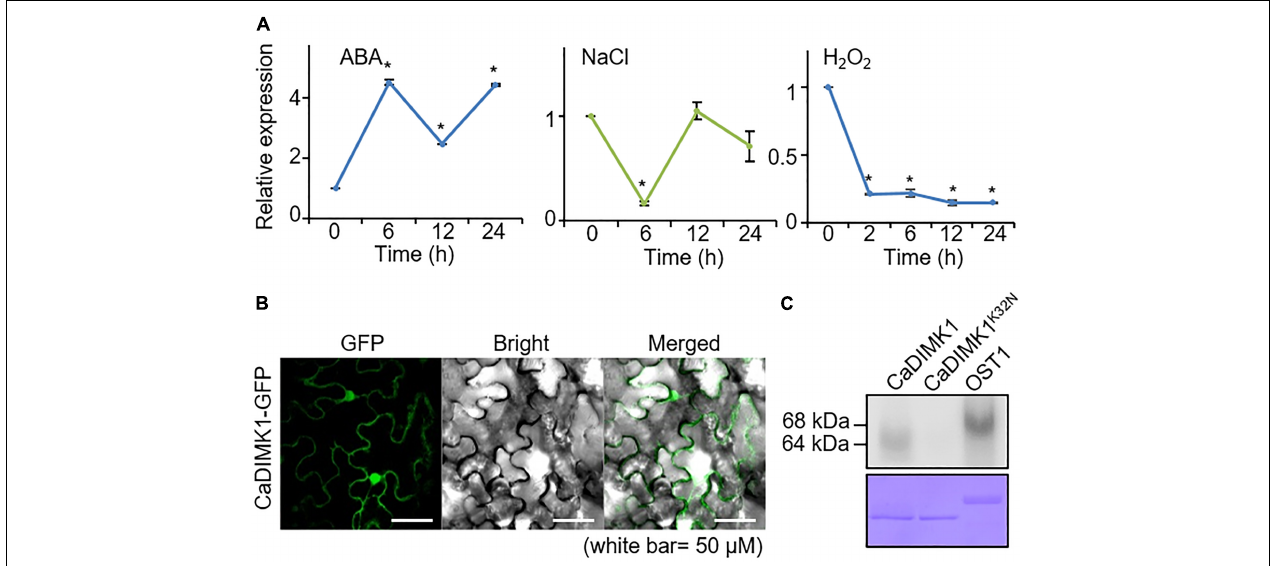
FIGURE 3 | Expression of CaDIMK1 gene and subcellular localization of CaDIMK1 protein. (A) Induction levels of CaDIMK1 in pepper plant leaf tissue treated with abscisic acid (ABA; 100 µ M), sodium chloride (NaCl; 200 mM), and hydrogen peroxide (H 2 O 2 ; 100 µ M). The expression values are normalized to pepper Actin1 ( CaACT1 ) gene as a standard control. The induction level of CaDIMK1 at 0 h after treatment was 1.0. Values are mean ± SE, n = 3; asterisks indicate statistical differences compared with 0 h after treatment according to Student’s t -test (* P < 0.05). (B) Subcellular localization of CaDIMK1 protein in the epidermal cells of Nicotiana benthamiana . The transient expression of 35S: CaDIMK1-GFP construct was expressed in N. benthamiana leaves and detected using a confocal microscope. (C) In vitro auto kinase assay of GST- CaDIMK1 and GST- CaDIMK1 K36N . [ γ − − 32 P]-ATP was used for kinase assay. As a positive control, Arabidopsis OST1 was used. CBB, Coomassie brilliant blue staining.